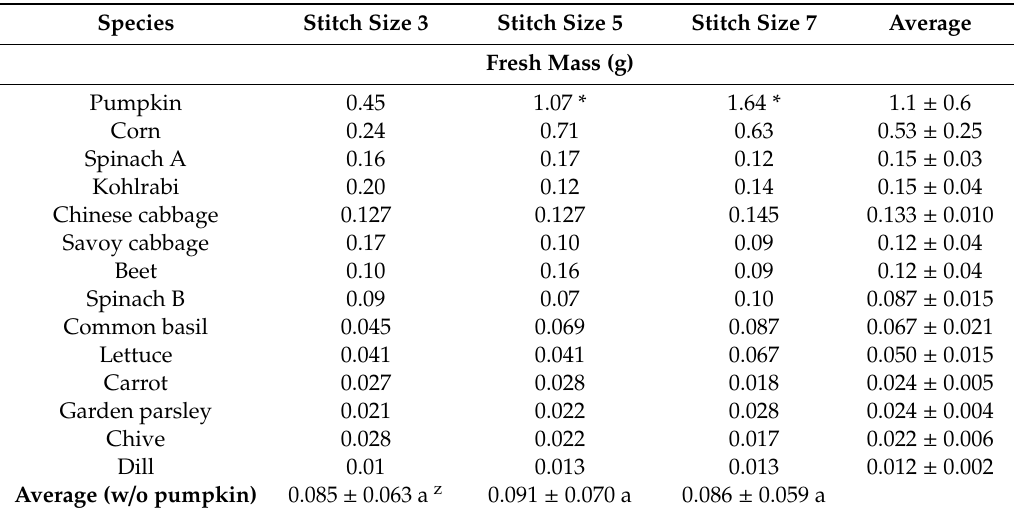
Table 4. Fresh masses per seedling of shoot tissue above the textile fabrics, sorted by the average fresh mass. An * indicates the two pumpkin seedlings whose integuments were still attached and which thus were included in the mass.